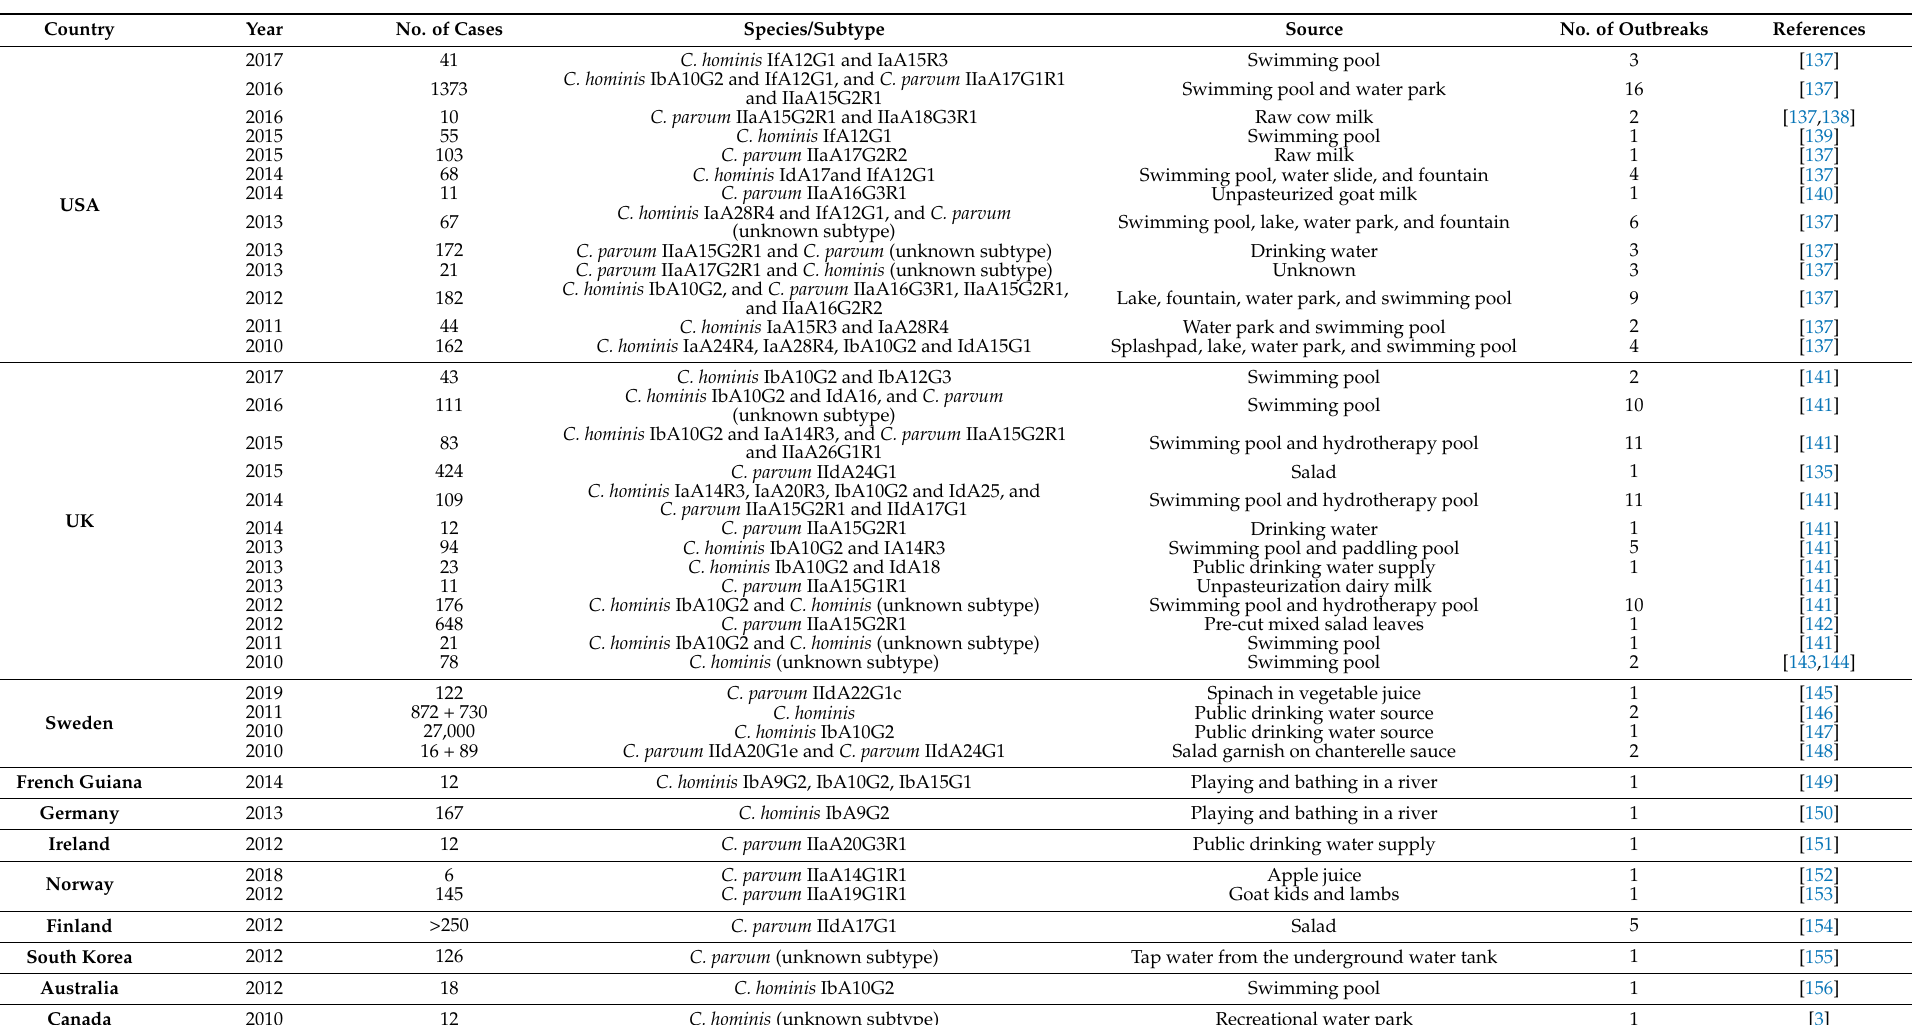
Table 4. Recent reported outbreaks of human cryptosporidiosis